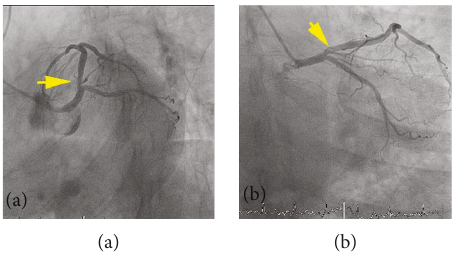
Figure 1: Angiographic view of the left anterior descending artery. (a, b) Mildly hazy lesion in the ostial LAD (yellow arrow).